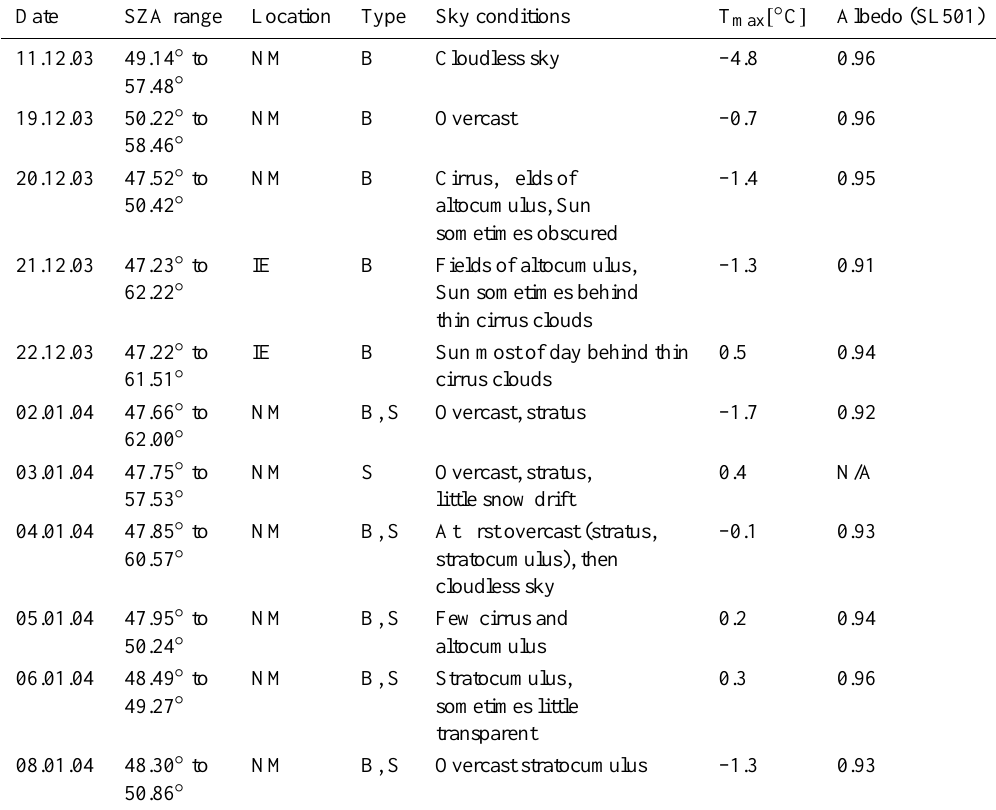
Table 3. Summary of the conditions when albedo measurements have been performed. The date, range of SZA, location (NM: Neumayer Station, IE: Ice Edge), type of instrument used (B: Broadband SL501, S: Spectroradiometer), sky conditions, and maximum temperature are